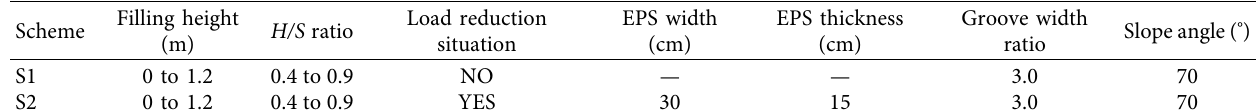
Table 1: Scheme design.